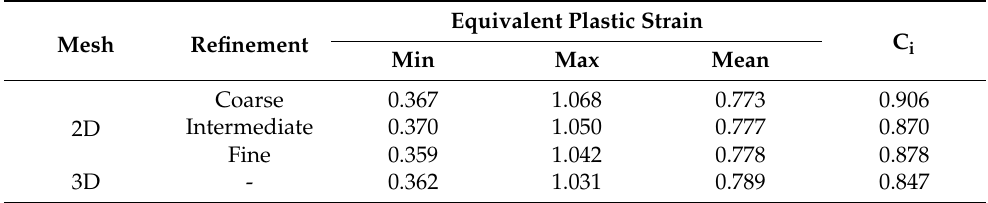
Table 2. Values of ε pl,i , with i: max, min, and mean and C i (Equation (1)) for the meshes shown in Figure 7.